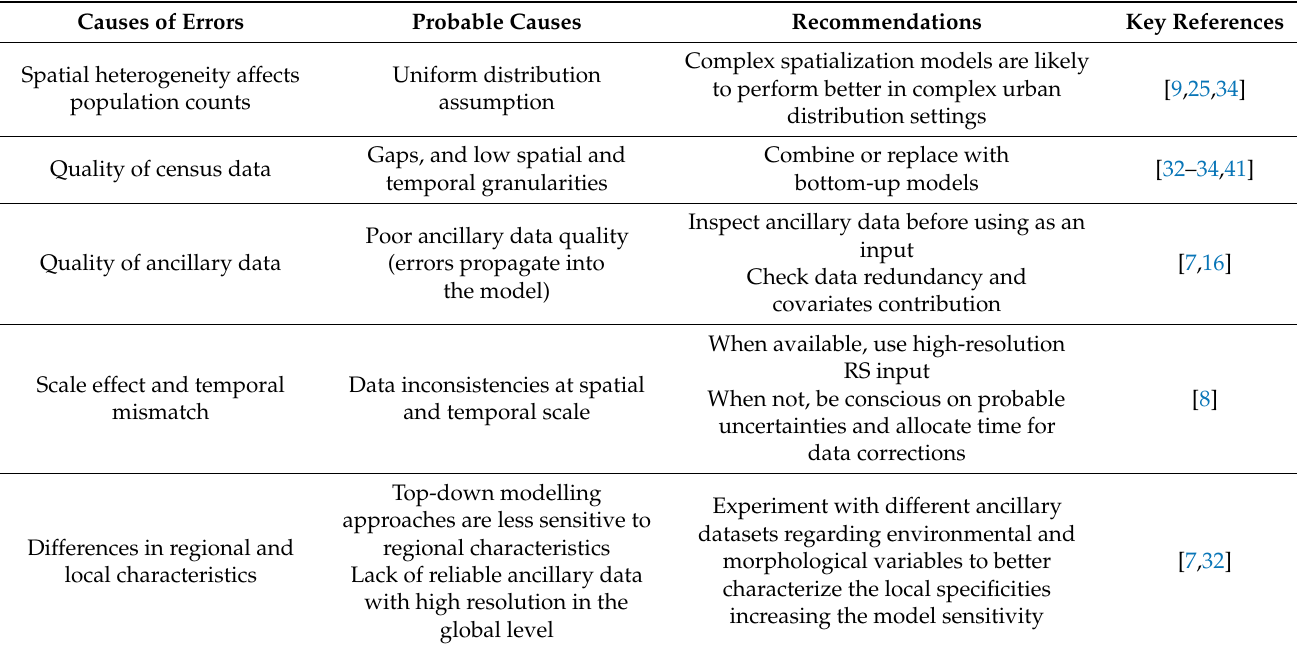
Table 2. Common causes of errors in modelling approaches and suggested solutions from literature.